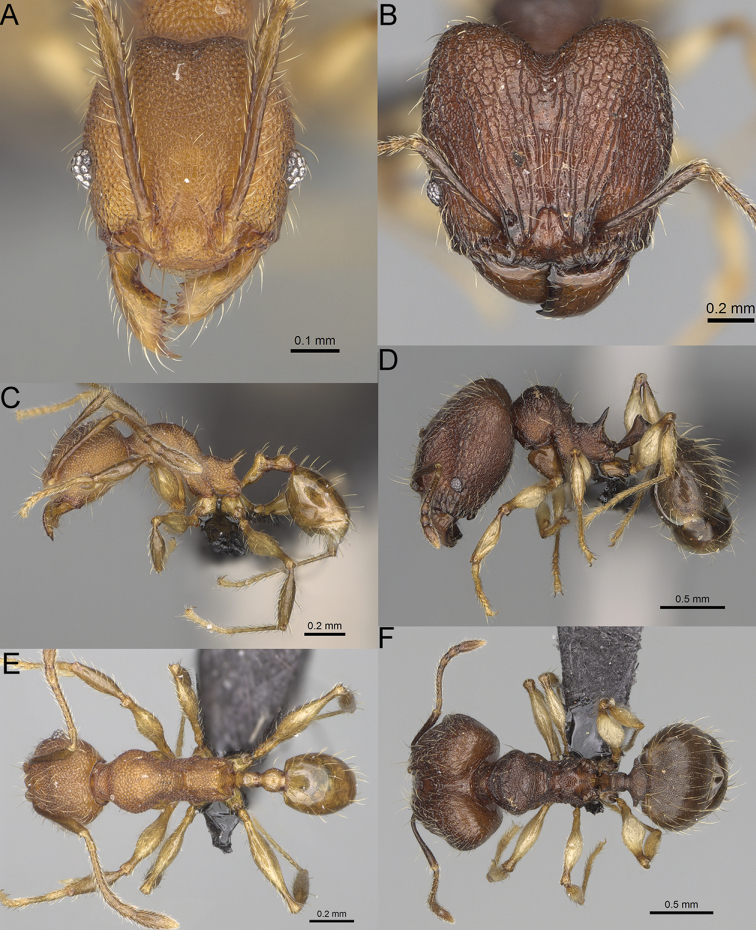
Pheidole
manantenensis sp. nov., full-face view (A), profile (C), and dorsal view (E) of paratype minor worker (CASENT0923218) and full-face view (B), profile (D), and dorsal view (F) of holotype major worker (CASENT0068456).